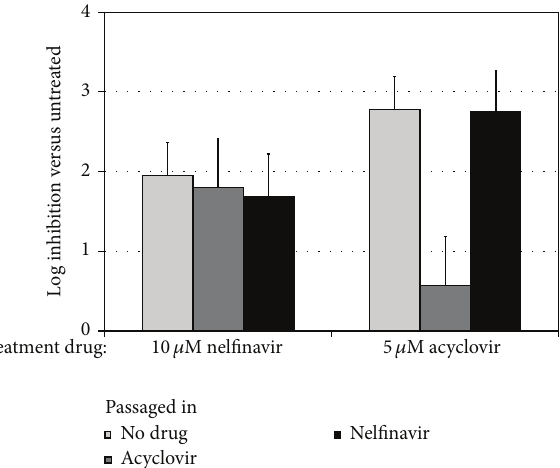
Figure 1: NFV inhibits production of infectious HSV-1 through a mechanismdistinctfromthatofacycloviranddoesnotreadilyselect for antiviral resistance in vitro . HSV-1 was passaged four times in HF in the presence of either 5 𝜇 M NFV or 1 𝜇 M acyclovir, the approximate IC 50 of each drug. Virus passaged in acyclovir showed increased resistance to inhibition by acyclovir but was inhibited by NFV similarly to the control HSV-1 isolate. In contrast, passage in the presence of NFV did not result in a significant change in sus- ceptibility to either drug. Shown are the results from three separate